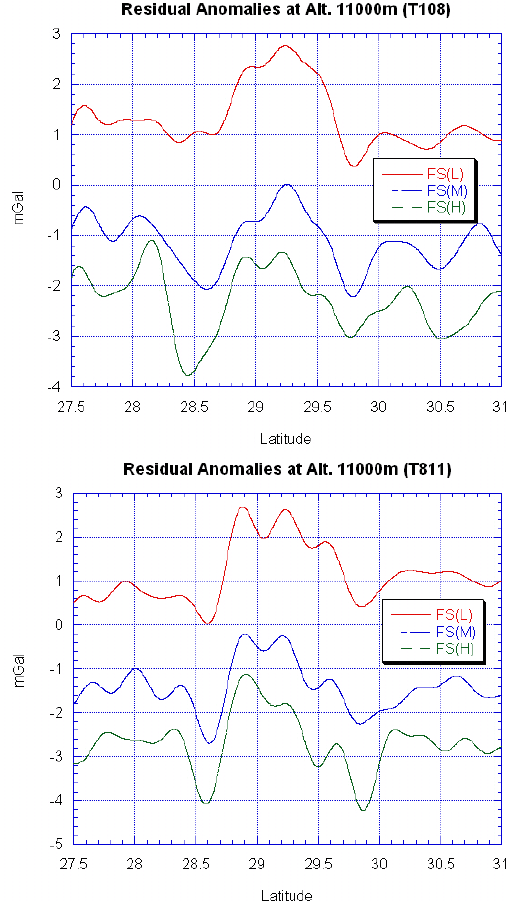
Figure 2. Gravity anomalies along track T108 (upper panel) and T811 (bottom panel) at the altitude of 11000 m. FS(L), FS(M) and FS(H) are the gravityanomalies computed from Fourier series determined using data at altitude of 1700 m (L), 6300 m (M), and 11000 m (H). GA(H) is airborne grav- ity at altitude of 11000 m before Fourier series fitting.